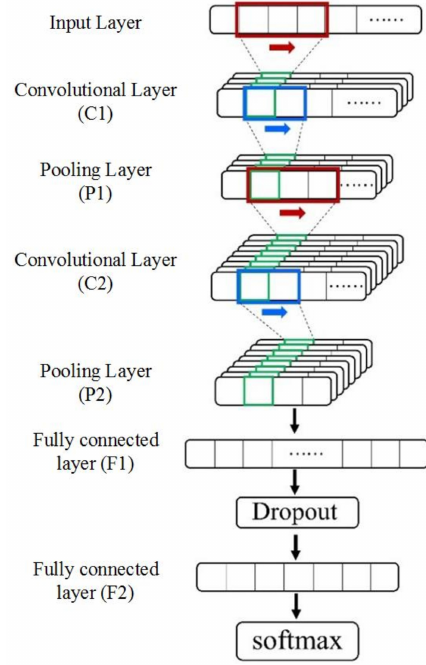
Figure 8. The network structure of CNN used in this